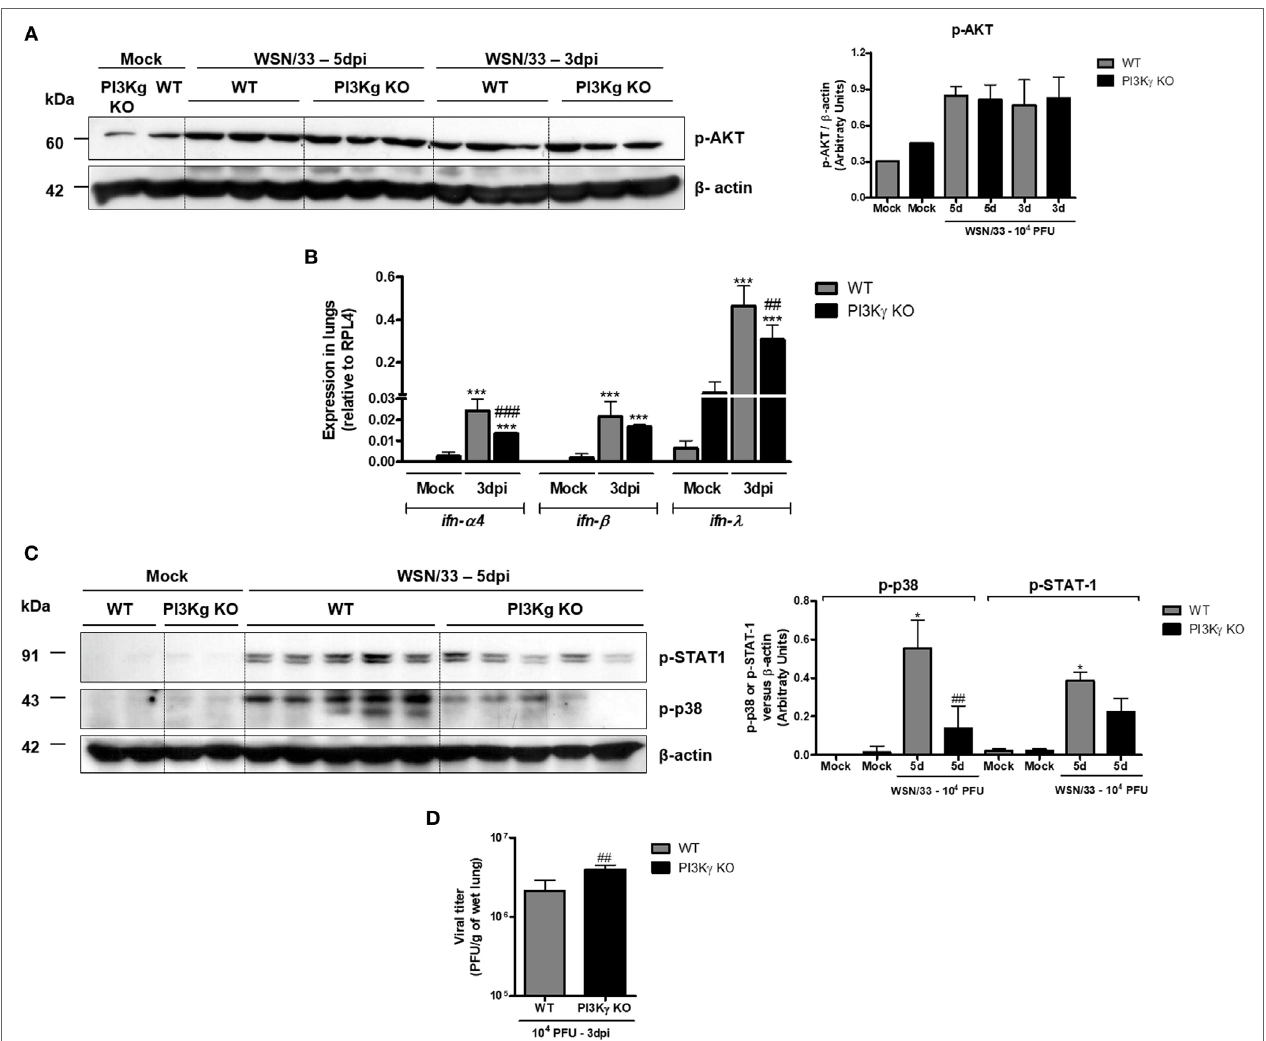
FigUre 3 | Reduced type-I and type-III IFN and p38 activation in phosphatidyl inositol 3 kinase-gamma (PI3K γ ) knockout (KO) mice infected with influenza A virus are related to higher viral loads in early time points. WT and PI3K γ KO mice were instilled with phosphate-buffered saline or 10 4 plaque-forming units (PFU) of influenza WSN and euthanized at day 3 or 5 after infection (representative of two experiments showing n = 4–5 mice per group). Phosphorylation of (a) AKT in lung extracts from WT and KO mice at 3 and 5 days after infection. (B) Lung mRNA levels of ifn- α 4 , ifn- β , and ifn- λ by real-time qPCR. (c) STAT-1 (upper) and p38 phosphorylation (middle) at day 5 after infection on the same membrane; β -actin was a loading control (lower); densitometry analysis was performed, comparing signals of analyzed protein versus loading control (right). (D) Viral loads in lungs were assessed by plaque assay in Madin–Darby Canine Kidney cells at day 3 after infection. Results are presented as mean ± SD. *** p < 0.001, when compared with each Mock group; ## p < 0.01 and ### p < 0.001, comparing PI3K γ KO to WT-infected mice [ (B) one-way ANOVA, Newman–Keuls; (D) t